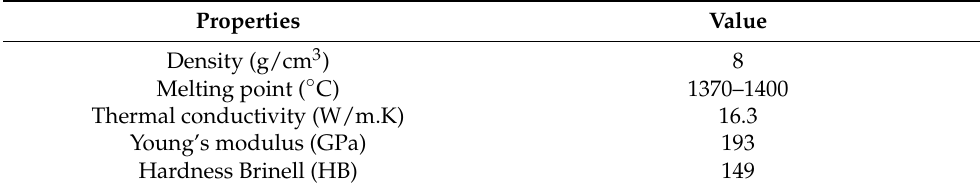
Table 2. Mechanical and thermal properties of 316 stainless steel [40].